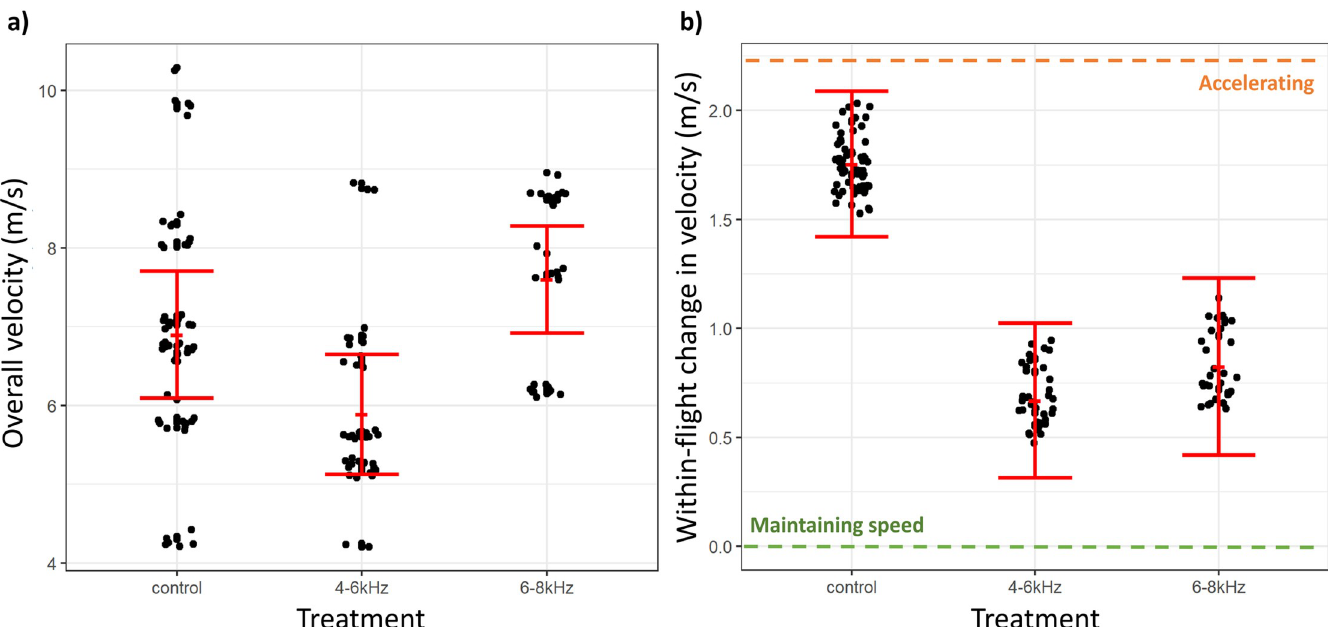
Fig 4. Flight velocity by treatment condition. Panel a) shows the overall flight velocity by treatment condition. Panel b) shows the within-flight change in flight velocity by treatment condition. Solid red dots and error bars represent model-averaged mean of outcome variable ± standard error of the mean. In panel b), the green dotted line indicates the level of change in velocity representing a maintaining of flight speed and the orange dotted line indicates the level of change in velocity representing an acceleration in flight speed.